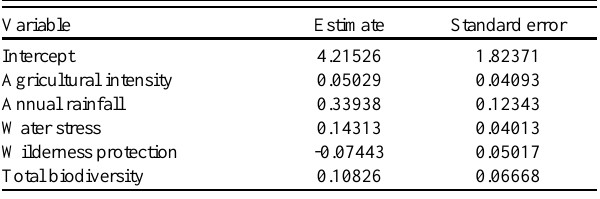
Table 4 . Parameter estimates for variables selected in the best model of social-ecological factors and the proportion of endangered mammals in 100 different countries.